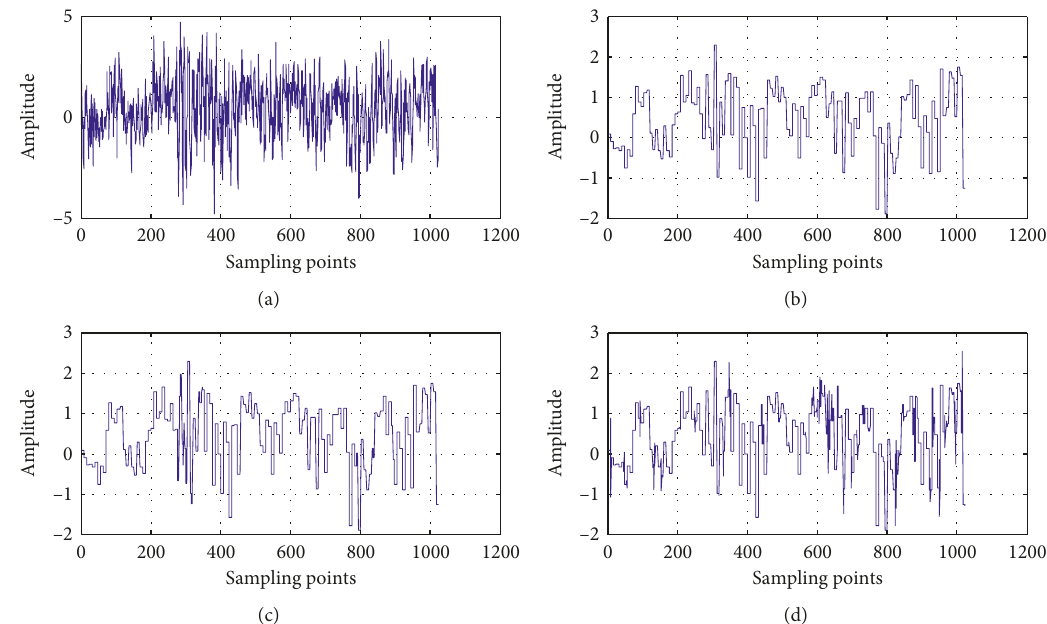
Figure 11: Outer wear signal and the waveform after denoising. (a) Outer wear signal. (b) Hard threshold denoised signal. (c) Default threshold denoised signal. (d) Given soft threshold denoised signal.